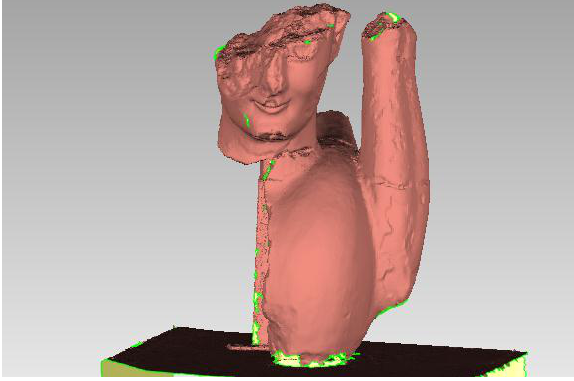
Figure 10. Identification of the homologous points